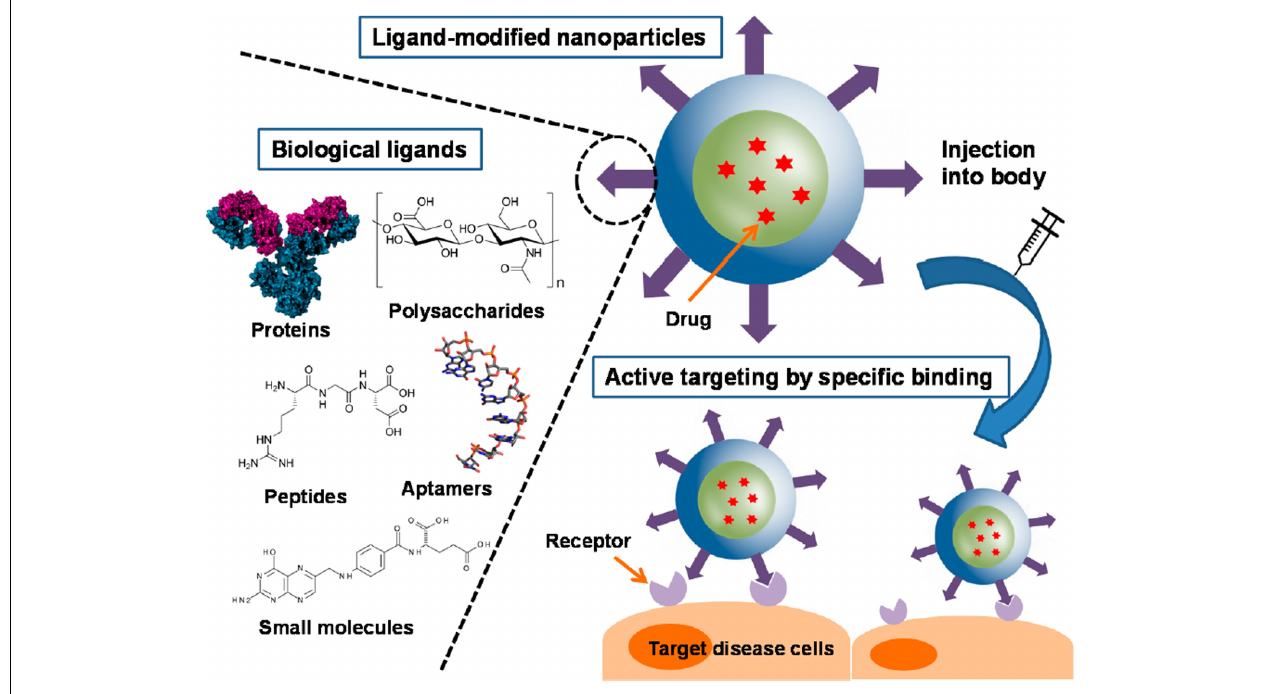
FIGURE 3 | Surface functionalized PLGA nanoparticles for active targeting and cellular binding reproduced from Yoo et al. (2019).